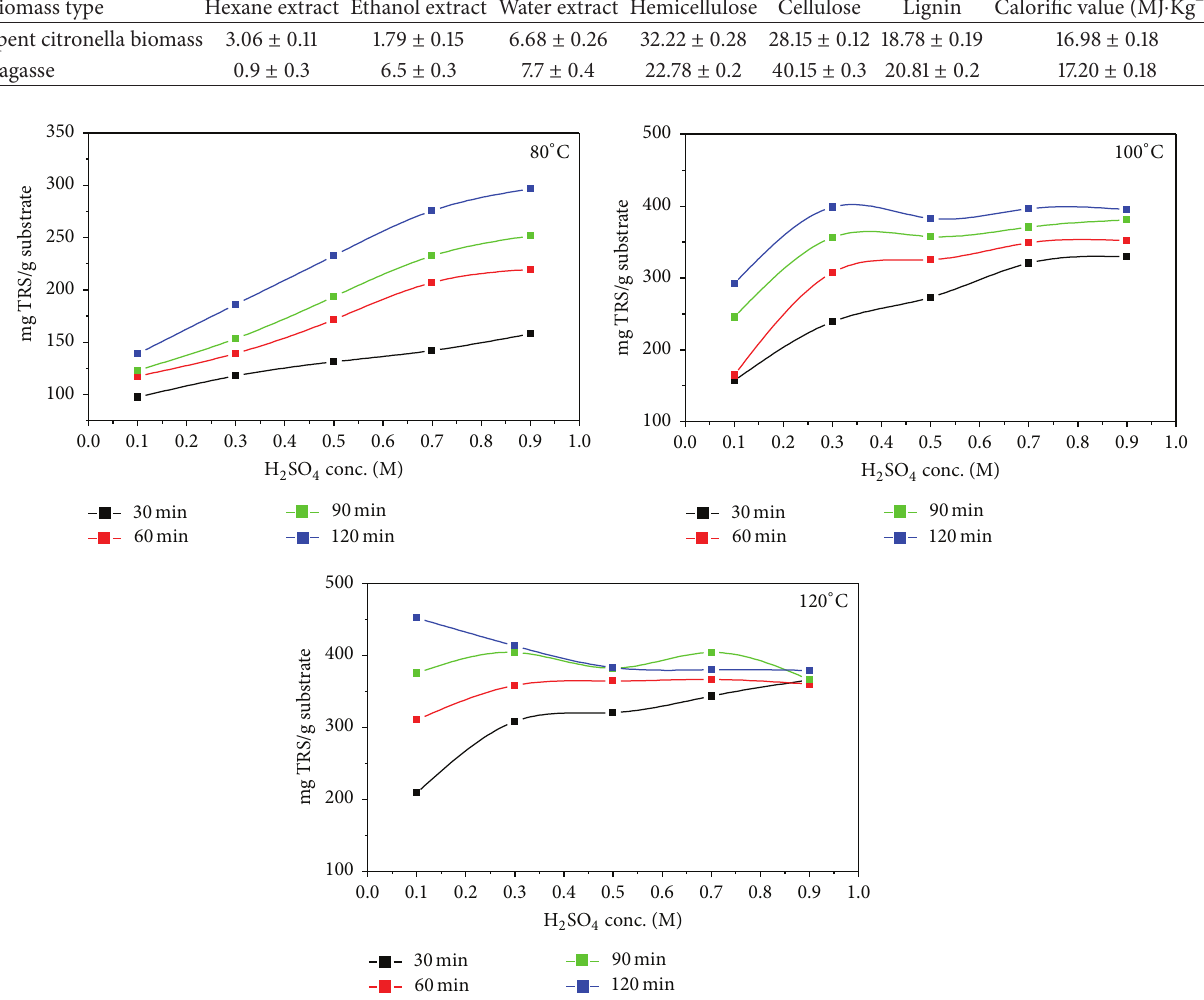
Figure 1: Effect of reaction time and H 2 SO 4 concentration at different temperature on the production of TRS from sugarcane